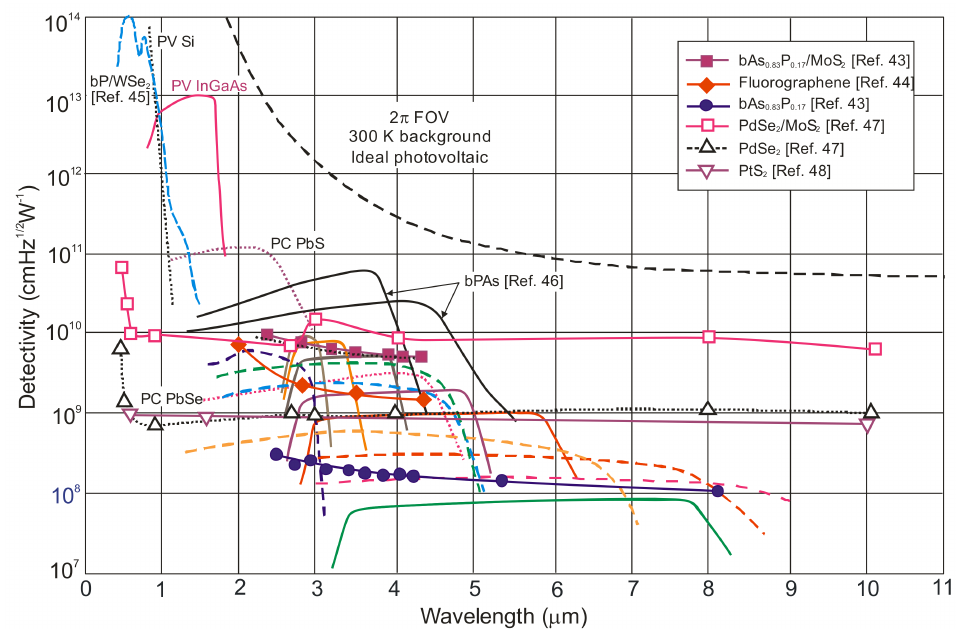
Figure 10. Room-temperature spectral detectivity curves of the commercially available photodetectors [PV Si and InGaAs, PC PbS and PbSe, HgCdTe photodiodes (solid lines reference [33])]. The spectral detectivity curves of new emerging T2SL IB QCIPs are marked by dashed lines (reference 38). Also the experimental data for different types of 2D material photodetectors are included. Experimental data is taken from [43–48]. PC—Photoconductor,